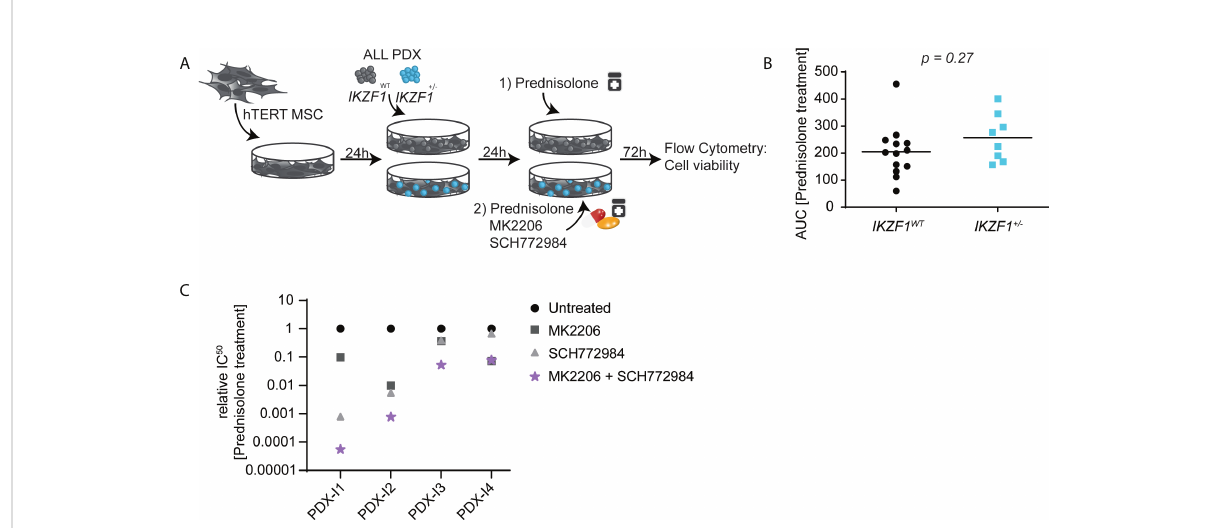
FIGURE 4 (A) Schematic overview representing the work fl ow used for ex-vivo co-cultures. In short, hTERT MSCs were seeded in 96-wells plate and allowed to settle for 24h before ALL-PDXs either wt or with a hemizygous IKZF1 deletion were added and again allowed to settle for 24h. Then, cells were incubated with different drug concentrations and after 3 days incubation, cell death was determined by using an amine-staining using Flow cytometry. (B) Cell viability determined by amine staining in patient-derived xenografts either wild type (black) or carrying a heterozygous deletion (blue) of IKZF1 depicted as Area Under the Curve. (C) Prednisolone induced cell death as determined by quanti fi cation of cells positive for amine-reactive dyes using fl ow cytometry in ALL-PDXs carrying a heterozygous deletion of IKZF1 . Cells were treated for 3-days with increasing concentrations of prednisolone in combination with MK2206 and/or SCH772984 after which IC50 values were calculated and plotted relative to prednisolone-only treated cells. The corresponding dose-response graphs are shown in Supplemental Figure 6. For PDX-I5, IC50 calculation was not possible and only the dose response is shown in Supplemental Figure